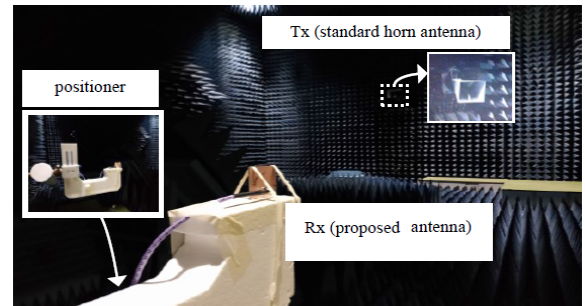
FIGURE 4 . Photos of the fabricated antennas with measurement setup. TABLE I. Various sizes of the suggested designs (units in mm) Parameters values α